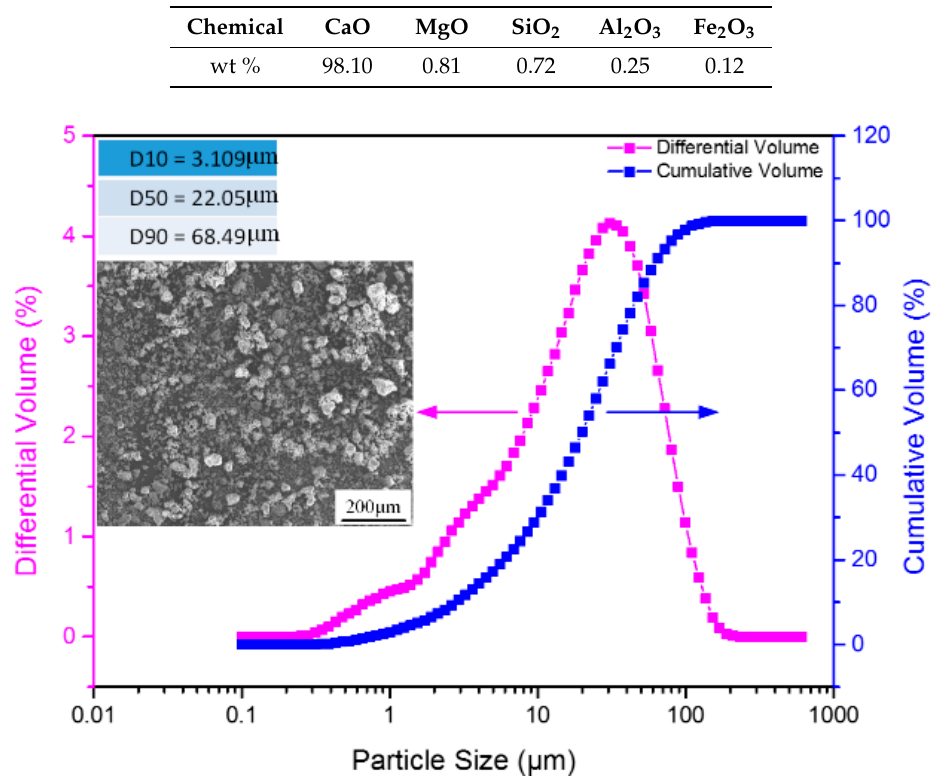
Table 1. Chemical analysis of raw CaO powder.